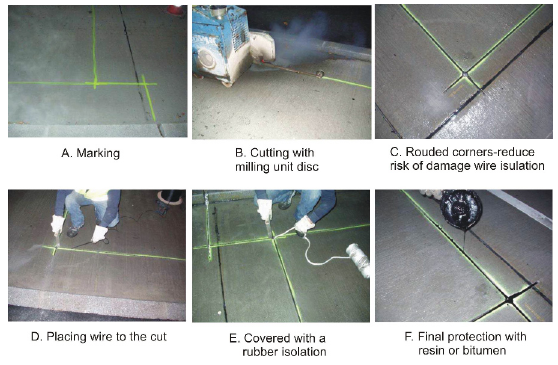
Figure 3. Image details of inductive